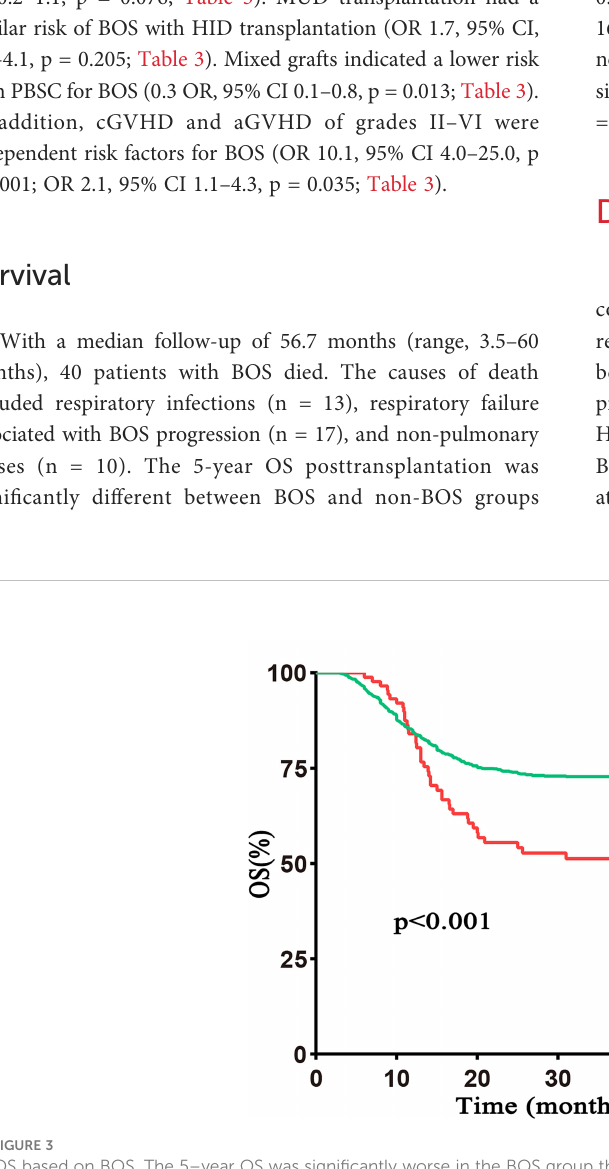
p = 0.480; Table 2, Figure 4C]. The effect of grafts on 5-year OS was not signi fi cant (mixed grafts vs. PBSC: 72.0% vs. 70.8%, p = 0.502; Figure 4D). Among the HID, MSD, and MUD groups, 5- year cumulative relapse rates were 12.7%, 15.9%, and 14.1% (p = 0.374; Figure 4E), and 5-year NRM rates were 19.9%, 14.8%, and 16.8%, respectively (p = 0.149; Figure 4G). Between the ATG and non-ATG groups, the 5-year cumulative relapse rates were not signi fi cantly different (p = 0.105), so was the 5-year NRM (p =